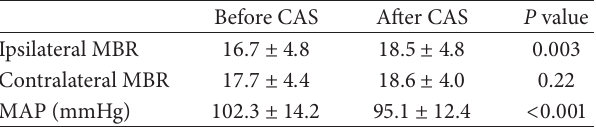
Table 1: Average MBR and mean arterial pressure.